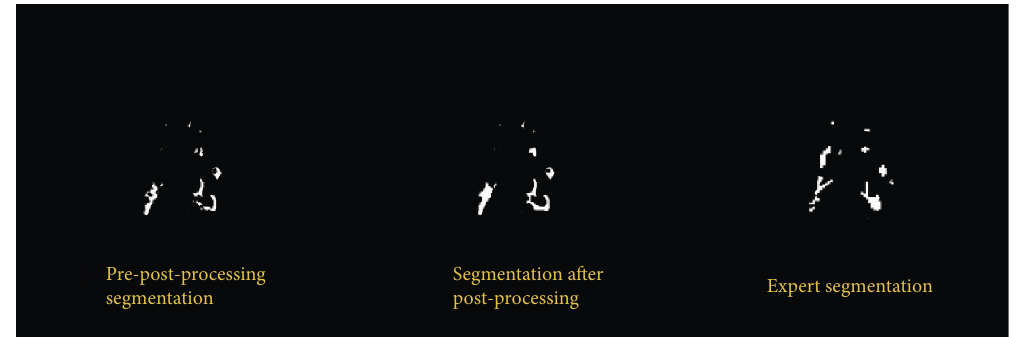
Figure 8: Example of the benefits of the closing